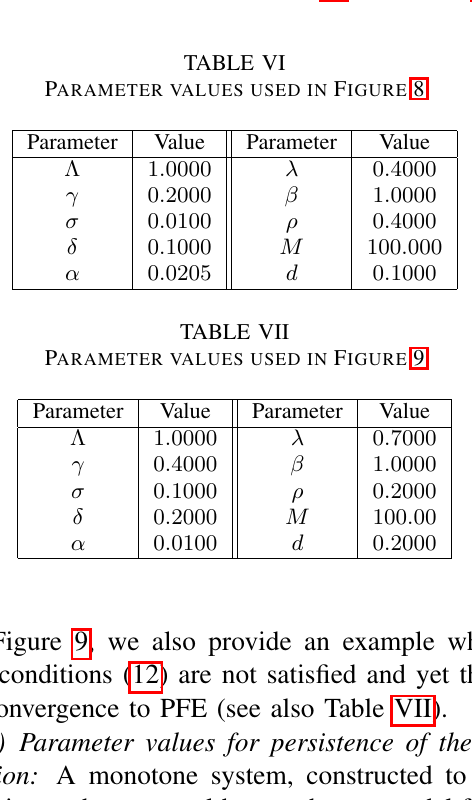
Fig. 7. Illustration of persistence of the infection when initial conditions do not satisfy conditions (32) in Theorem 3.